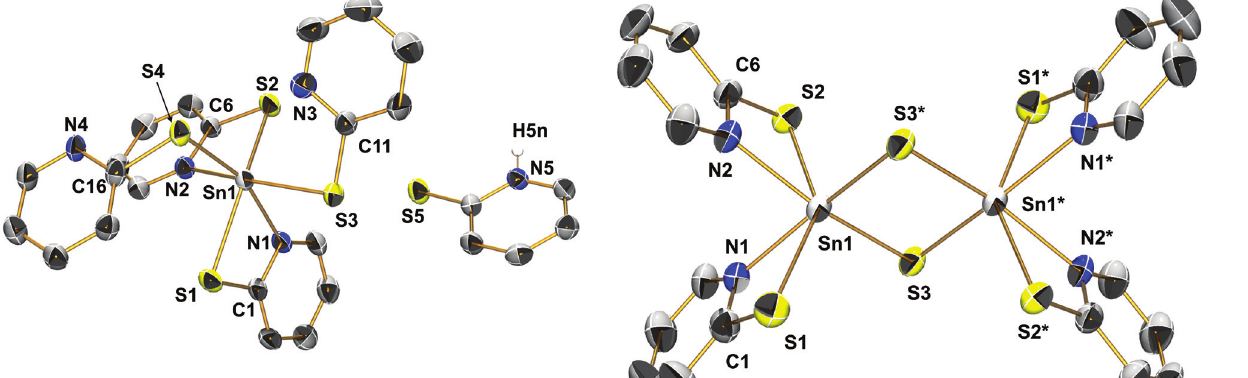
·HPyS in the crystal 4 ] in the crystal structure Figure 5 Molecular structure of [SnS(PyS) 2 2 of [SnS(PyS) ] ·THF. 2 2 ORTEP/POV-RAY diagrams (Farrugia, 1997; POV-RAY 3.6, 2004) with thermal displacement ellipsoids are shown at the 50% probability level. Selected atoms are labeled and hydrogen atoms and solvent molecule are omitted for clarity. The asymmetric unit comprises one half of a centrosymmetric cyclo-dimer. Symmetry-related atomic sites are indicated by * (for inversion 1-x, -y, -z). Selected bond lengths (Å) and angles ( ° ): Sn1-S1 2.5483 (7), Sn1-S2 2.5394 (6), Sn1-S3 2.4456 (6), Sn1-S3* 2.4615 (7), Sn1-N1 2.293 (2), Sn1-N2 2.266 (2), Sn1- S3-Sn1* 86.43 (2), S3-Sn-S3* 93.57 (2), S1-Sn1-S2 145.20 (2), N1-Sn1- N2 86.05 (7), N1-C1-S1 113.2 (2), N2-C6-S2 113.0